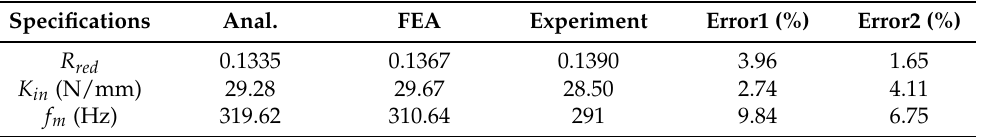
Table 3. Comparison results among the analytical model, FEA, and experimental test.